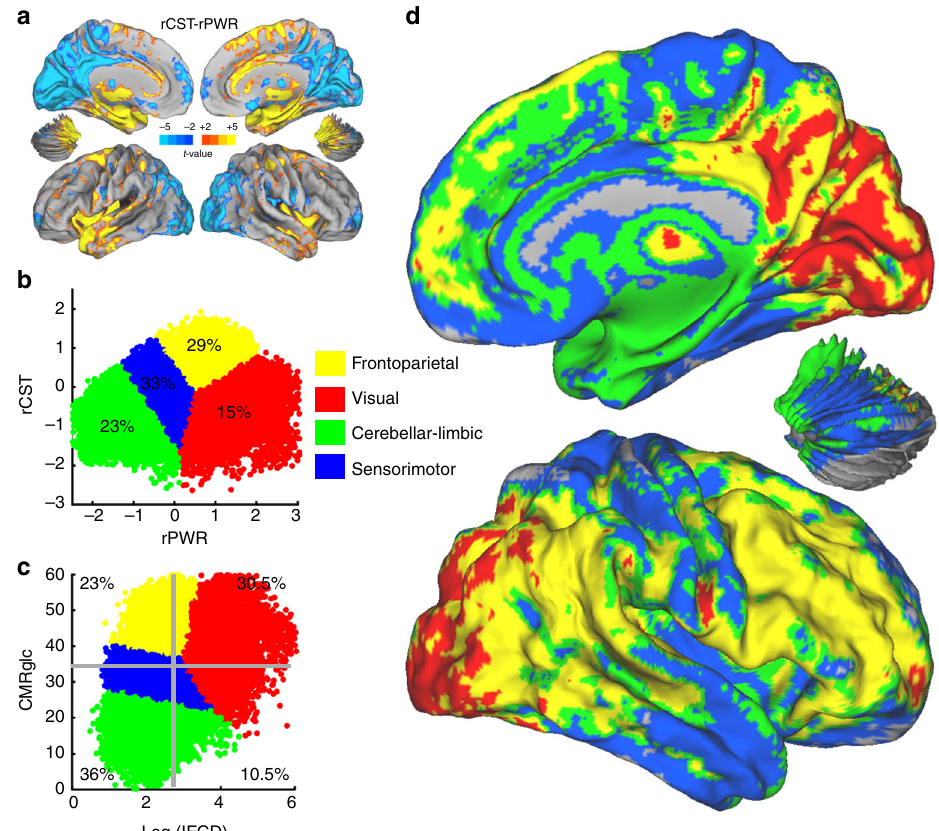
Fig. 3 Brain segmentation using relative power (rPWR) and relative cost (rCST) (cohort-1, n = 28). a rCST versus rPWR contrast showing precuneus and visual cortices with signi fi cantly lower rCST than rPWR, whereas superior frontal and insular cortices showed higher rCST than rPWR. For highlighting the extreme differences, we used a conservative threshold of p FWE < 0.01 at the voxel level (| t | > 6). At the conventional threshold ( p FWE < 0.01, cluster-size corrected), majority of the cortex (54%) showed differences in rCST versus rPWR (see Supplementary Table 3). b Scatter plot of rPWR versus rCST for all the brain voxels, showing the four k -means clusters with different colors. Numbers represent percentage of voxels falling within clusters. c Same clusters projected into the space of local functional connectivity density (lFCD) and cerebral metabolic rate of glucose (CMRglc). The thick gray lines mark the average of log(lFCD) and average of CMRglc with the number in each quadrant showing percentage of voxels falling within that quadrant. These quadrants are de fi ned in Fig. 1e. It is important to note that having a higher percentage of voxels associated with the high- and low-rPWR quadrants is consistent with log(lFCD) and CMRglc being positively correlated (see Fig. 1b). d The four k -means clusters in b on a surface rendering of the